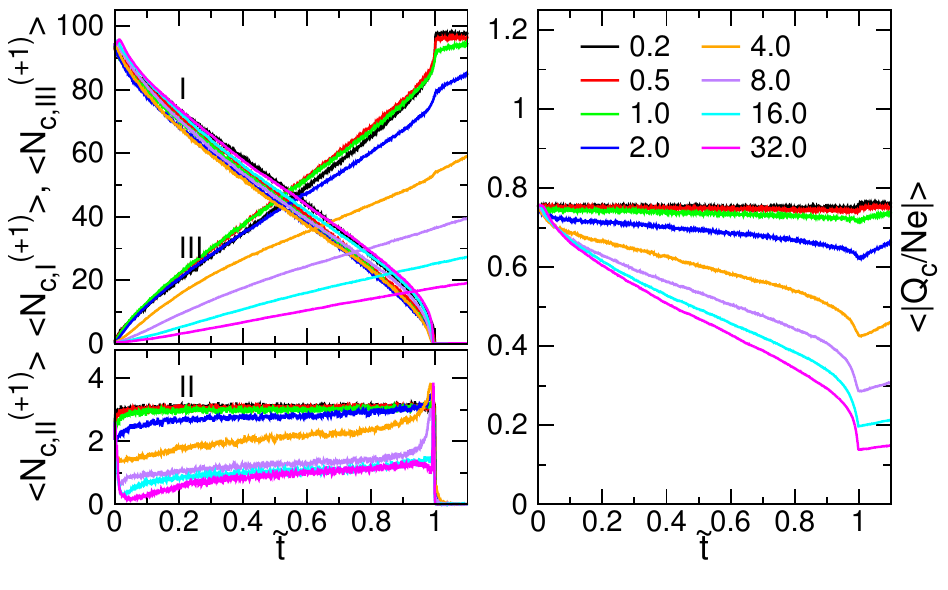
(+ 1 ) c in the cis-region (I),